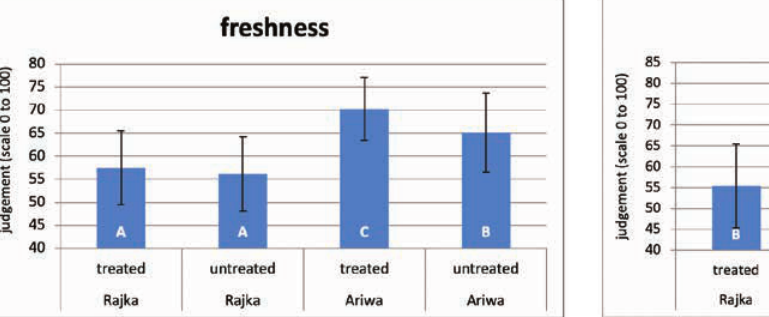
= 320, n = 80, means appels persons